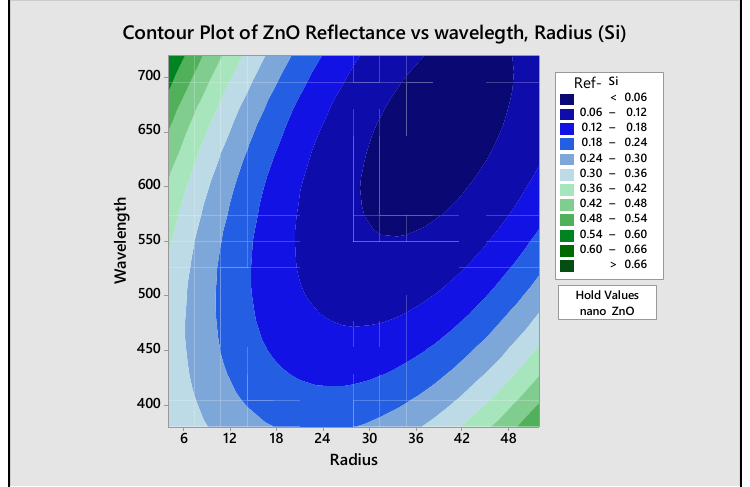
Figure 7. Contour plot of ZnO reflectance vs. wavelength and